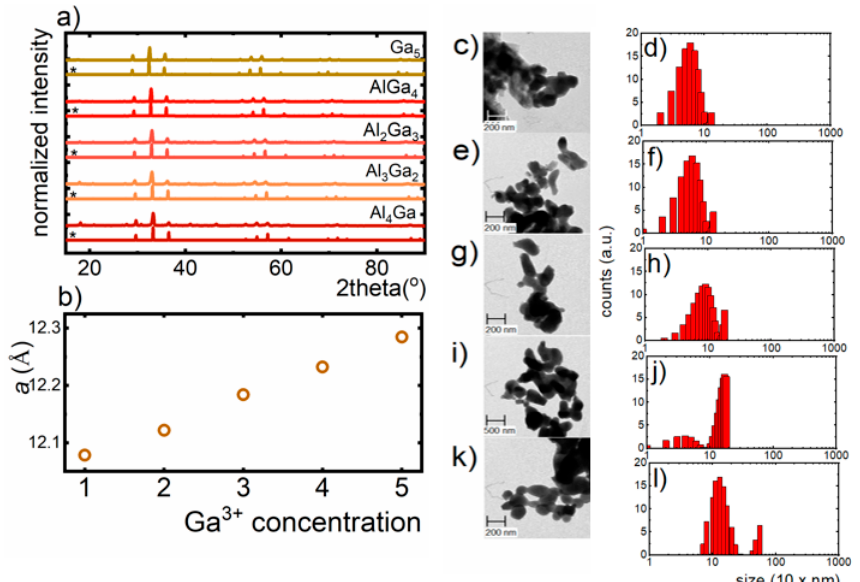
Figure 1. ( a ) XRD patterns of Y 3 Al 5 − x Ga x O 12 nanocrystals, doped with 0.1% V; ( b ) influence of the Ga 3+ concentration on the a cell parameter; ( c , e , g , i , k ): the morphology of Y 3 Al 4 GaO 12 , Y 3 Al 3 Ga 2 O 12 , Y 3 Al 2 Ga 3 O 12 , Y 3 AlGa 4 O 12 , Y 3 Ga 5 O 12 , respectively; ( d , f , h , j , l ): the distribution of the hydrodynamic size of aggregates.